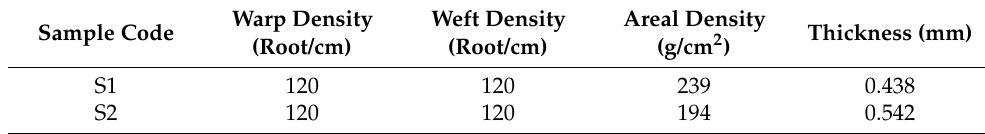
Table 3. Details of the prepared Song Brocade fabric.